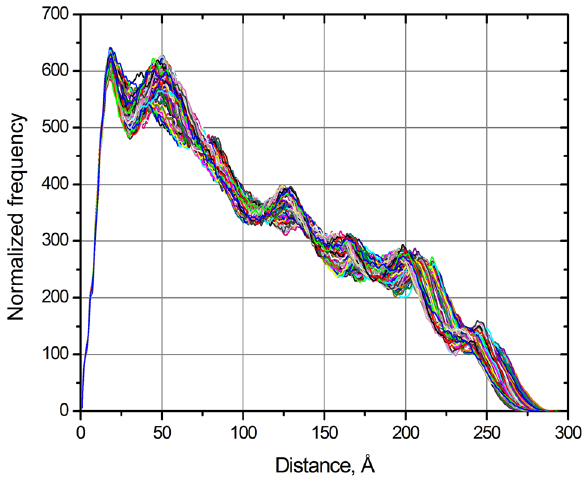
Figure 5. Calculated p ( r ) vs. r distributions for the 100 conformations generated in the DMD run on the AF-predicted O88338